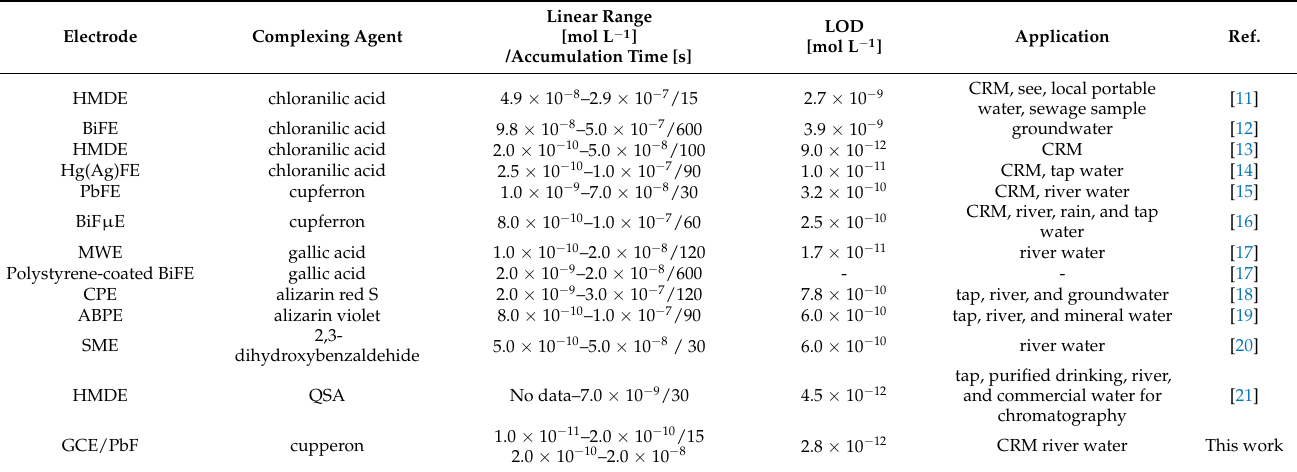
Table 2. Comparison of voltammetric procedures for V(V)